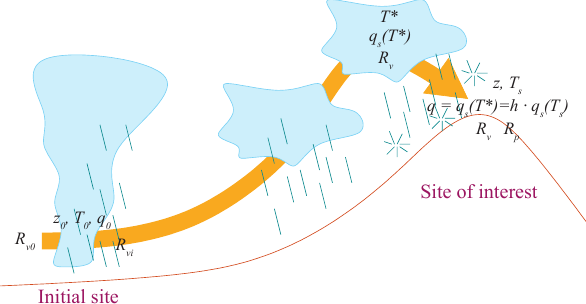
Figure 2. Idealized framework of an isolated air parcel transported from an initial site at low altitude to the site of interest. Most nota- tions are